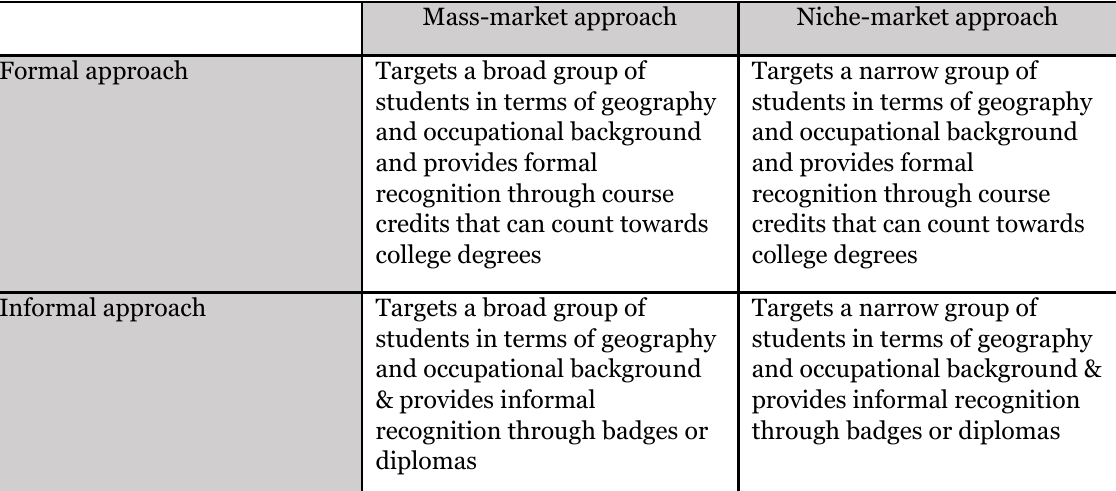
A Typology of MOOCs